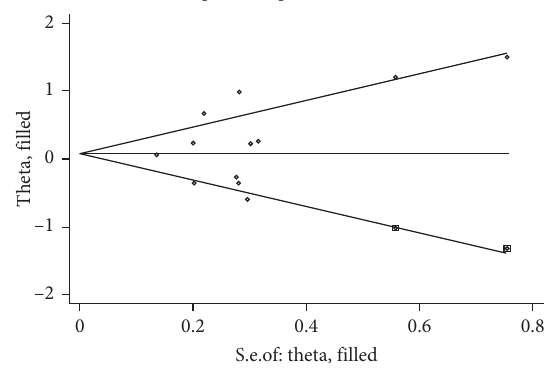
Figure 3: The filled funnel plot.